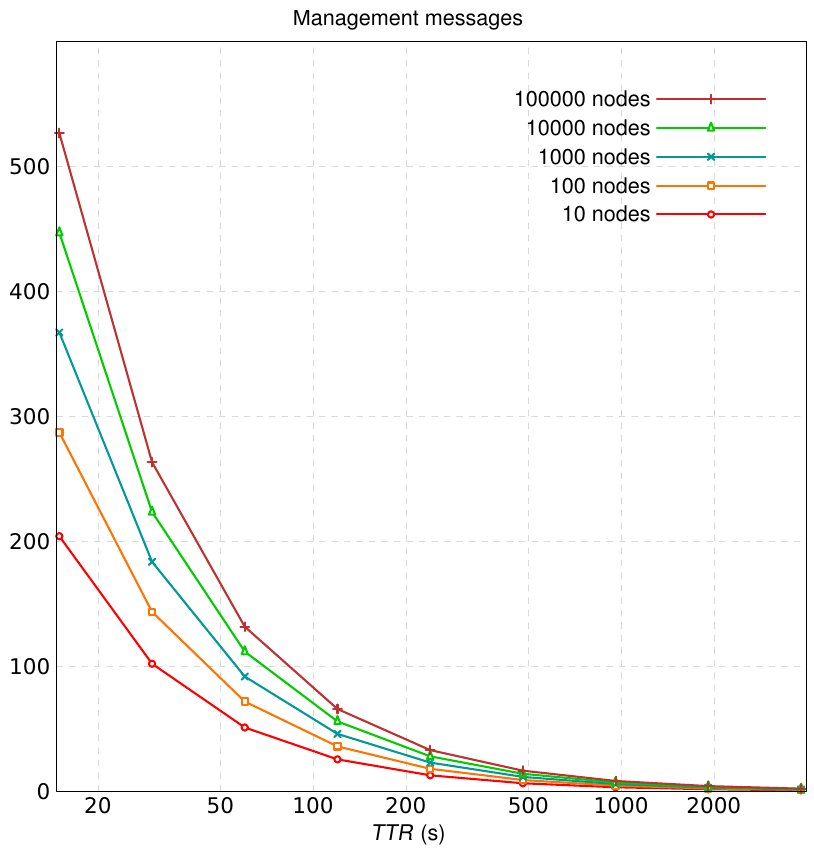
Figure 1. Number of management messages sent per minute for different refresh periods and population sizes, original